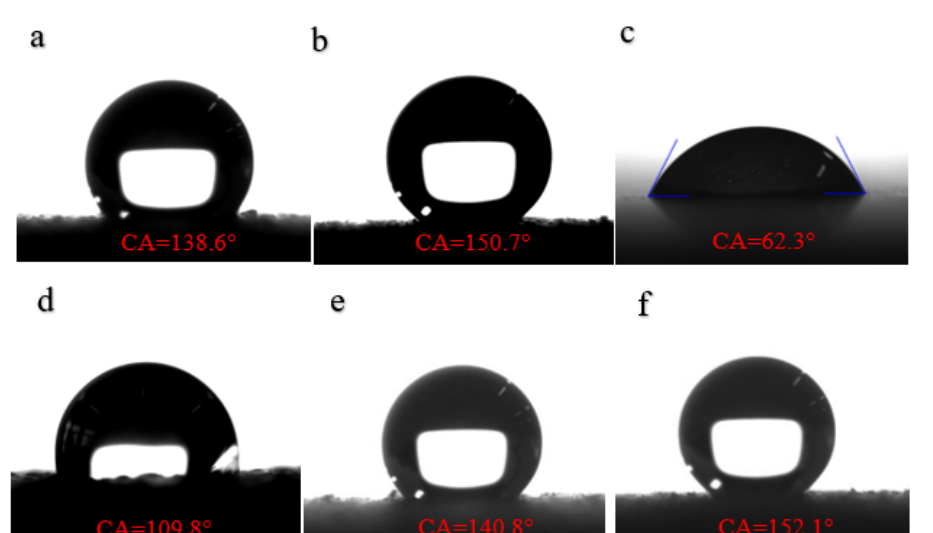
Figure 7. The CA of ( a ) MoS 2, ( b ) MoS 2 /ZnO, ( c ) no coating, ( d ) PDMS coating, ( e ) MoS 2 /PDMS coating, and ( f ) MoS 2 /ZnO/PDMS coating.